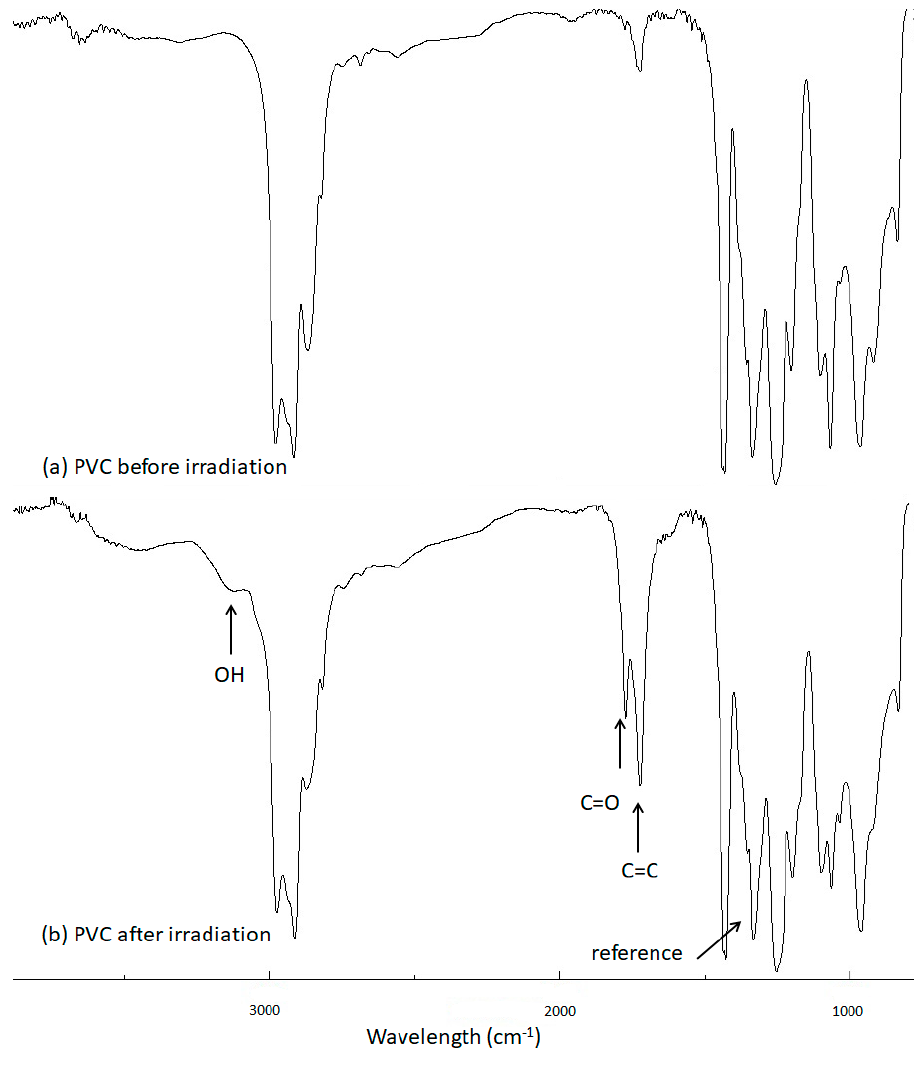
Figure 5. FT-IR spectra of PVC ( a ) before and ( b ) after irradiation.